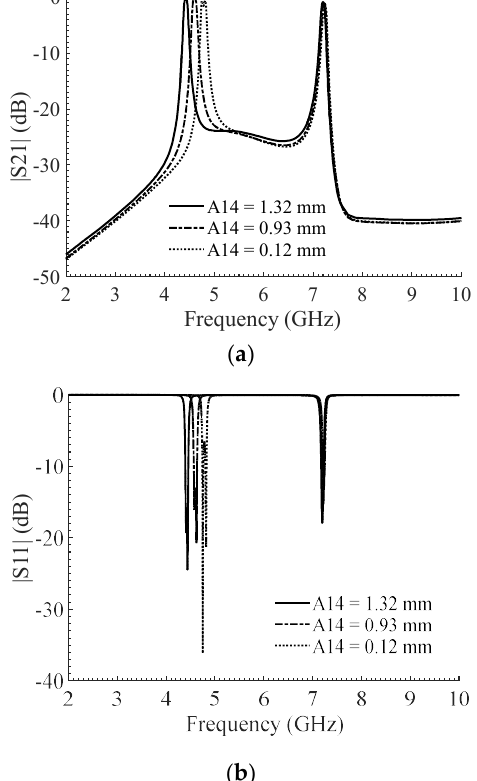
Figure 8. Adjustability of the lower band of the proposed BPF by varying A 14 : ( a ) |S 21 |, ( b ) |S 11 |.